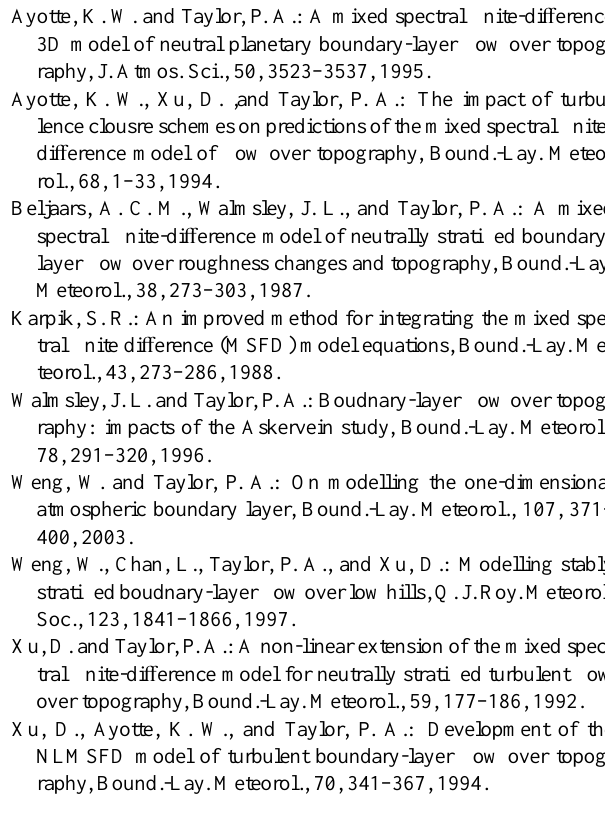
Figure 4. Fractional speed-up ratio, ∆ S , for flow over Askervein hill at a height of 10 m above topography along line AA. Comparison of model results and experimental data.